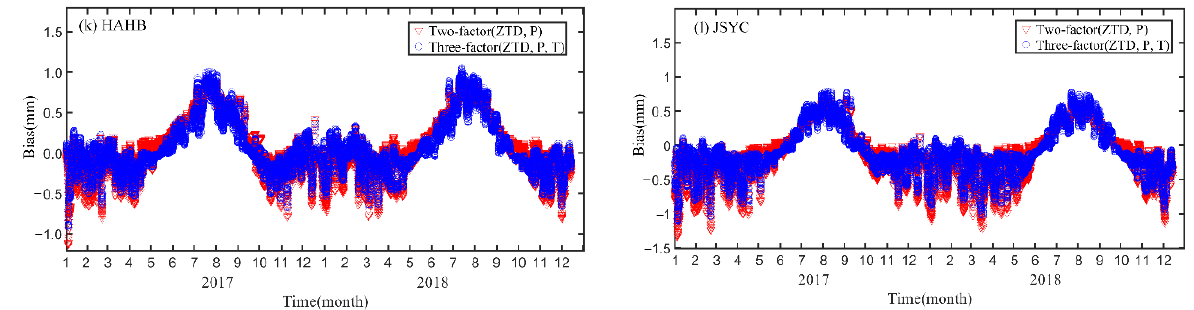
Figure 4. The deviations of the predicted PWV of 12 GNSS verification stations ( a – l ) during 2017–2018. It can be seen from Table 5 that the mean RMS of the two-factor PWV of the 12 GNSS stations during 2017–2018 was 0.31 mm, and the mean deviation was 0.16 mm. The mean RMS of the three-factor PWV was 0.33 mm, and the mean deviation was 0.16 mm. Therefore,